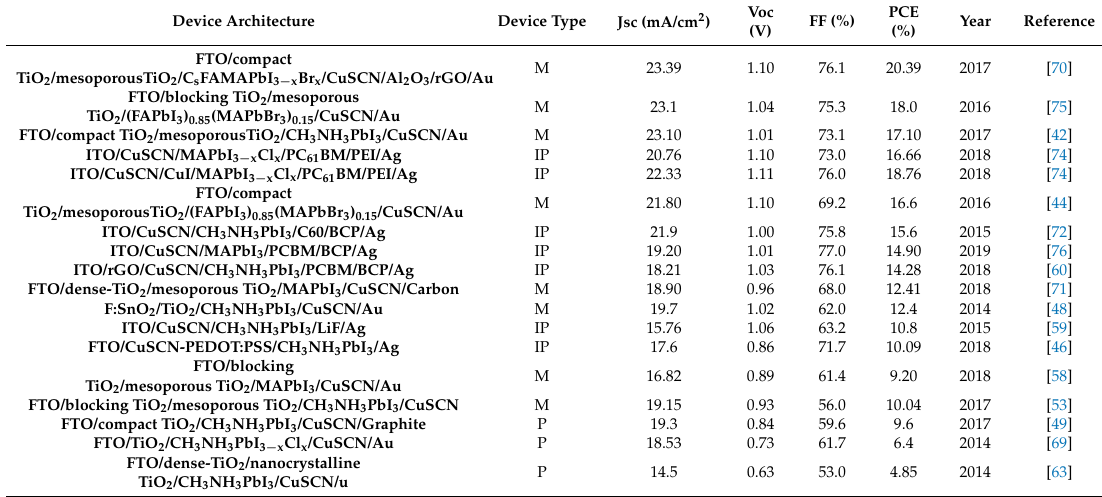
Table 5. Summary of photovoltaic device performance of CuSCN HTMs for